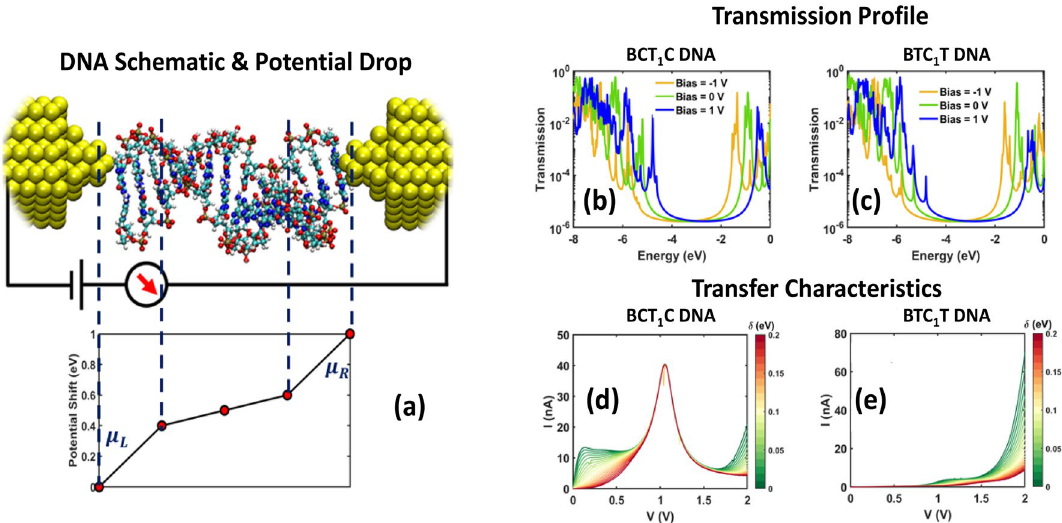
Figure 2. ( a ) A DNA strand is placed between two electrodes and a bias is applied across it. For our work, B conformation of two double stranded DNA sequences is considered, CT 1 C and TC 1 T. ( b , c ) Transmission versus energy for CT 1 C and TC 1 T strands as a function of Fermi energy for different bias voltages. ( d , e ) Current– voltage transfer characteristics for CT 1 C and TC 1 T B-DNA double stranded sequences. The collection of plots in these panels is for different Fermi energies ( δ